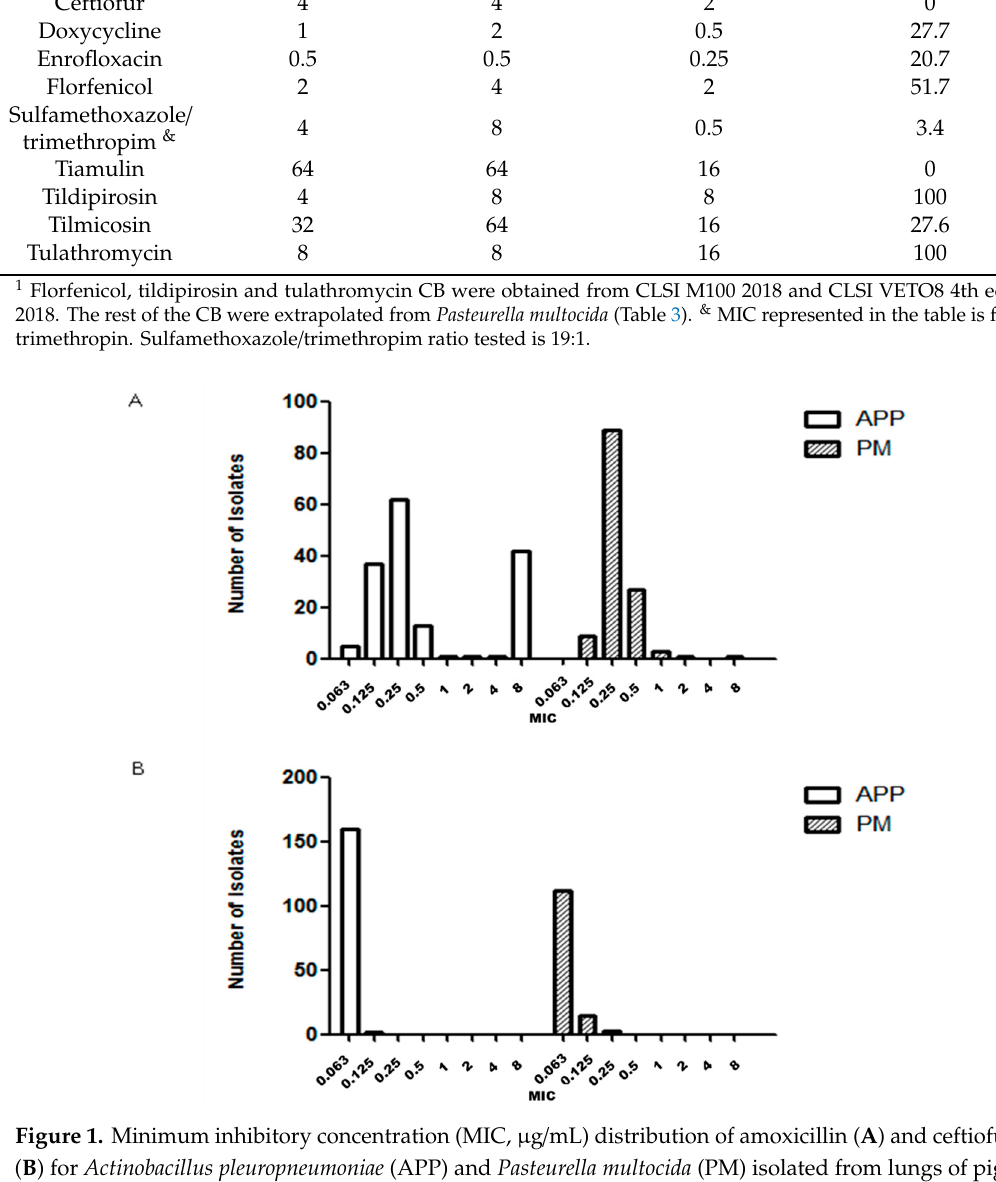
Figure 2. Minimum inhibitory concentration (MIC, μ g/mL) distribution of enrofloxacin ( A ) and doxycycline ( B ) for Actinobacillus pleuropneumoniae (APP) and Pasteurella multocida (PM) isolated from lungs of pigs with respiratory symptoms.